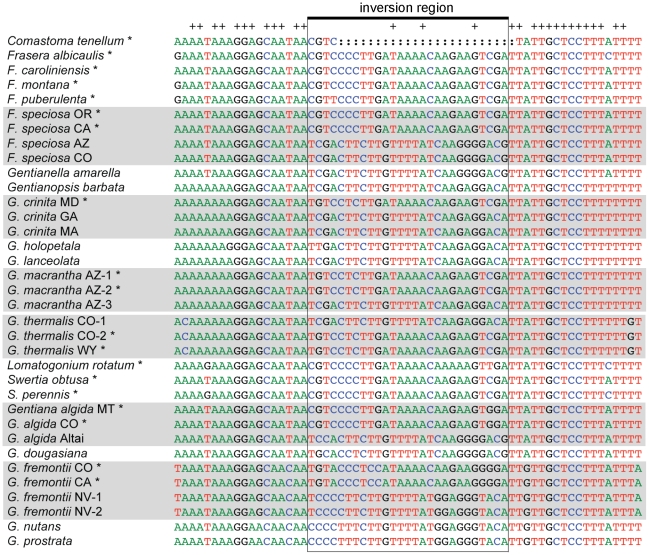
Portion of 35 trnH-psbA sequences including 25–27bp inversion and 18bp flanking inverted repeats.Groups of conspecific sequences are shaded. Asterisks mark sequences with the A inversion configuration. Plus signs at the top of the alignment mark invariant sites. Inversion region is in box.